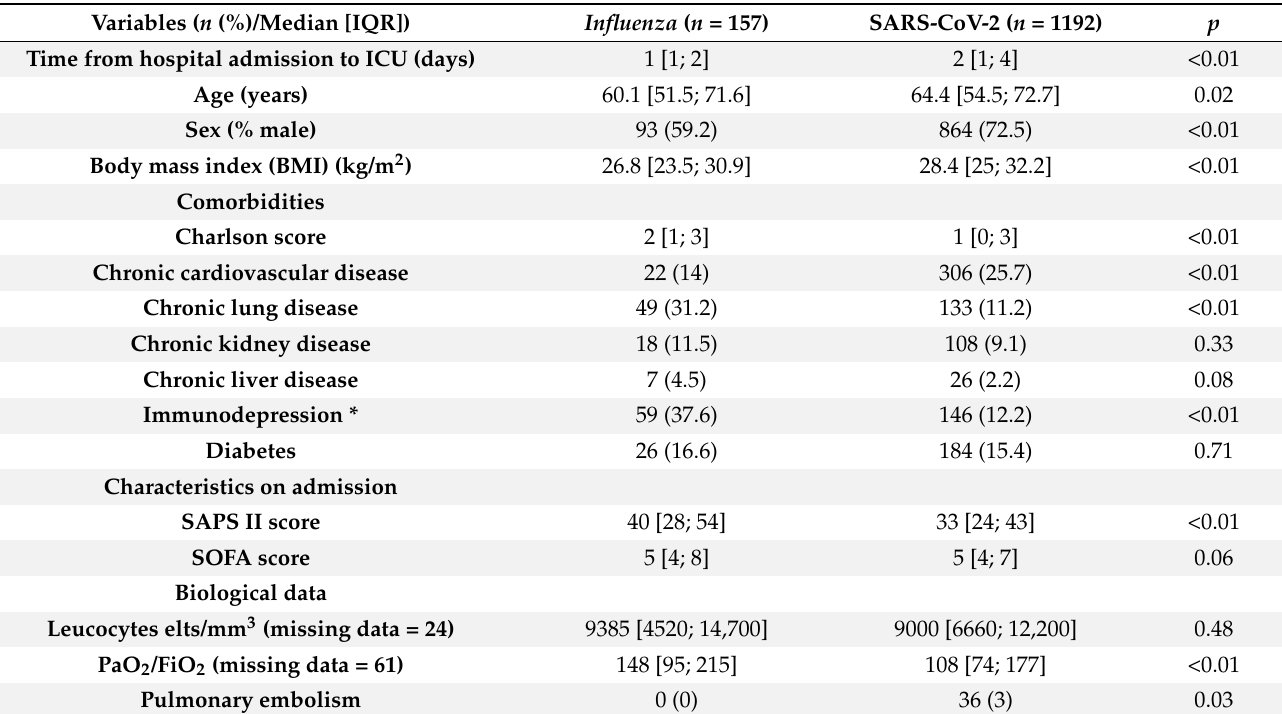
Figure 1. Flow diagram. Table 1. Comparison between patients with influenza pneumonia and SARS-CoV-2 pneumonia.